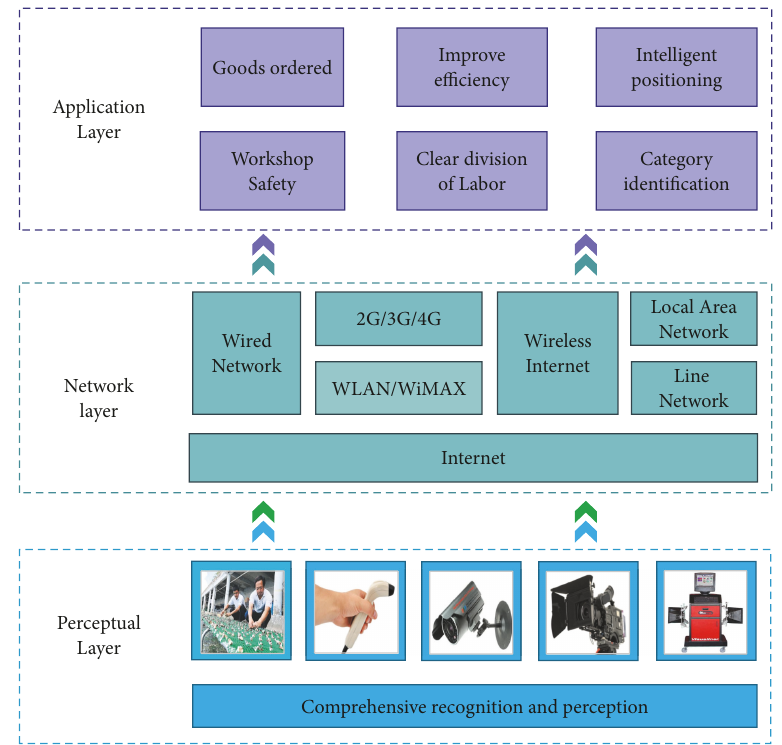
Figure 4: Internet of Things technology